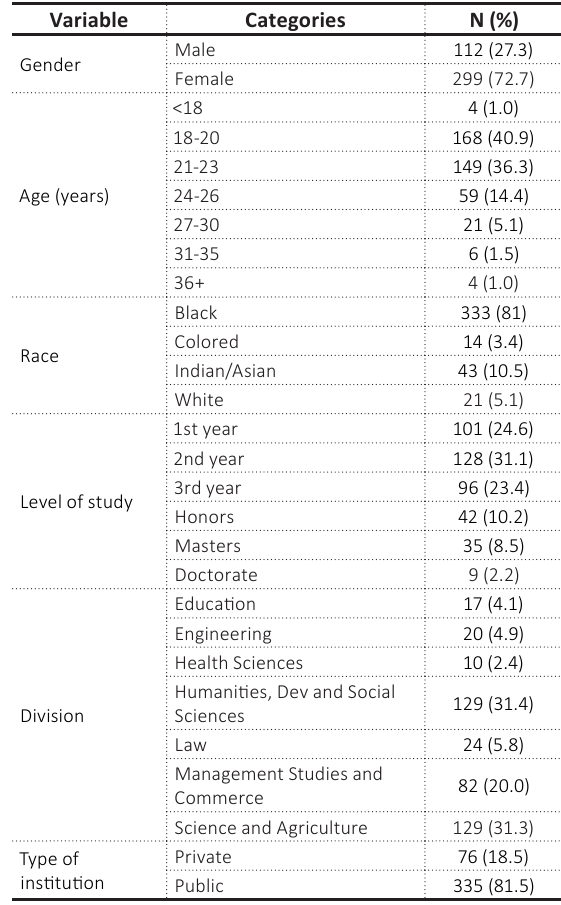
Table 1. Socio-demographic characteristics of the